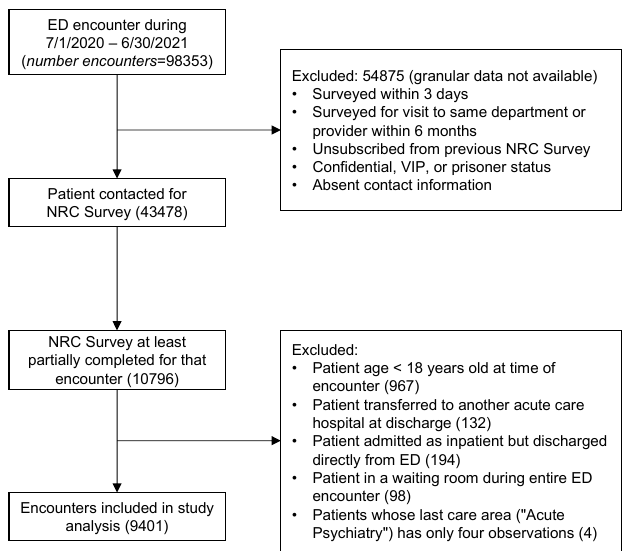
Figure 1. Inclusion criteria flow